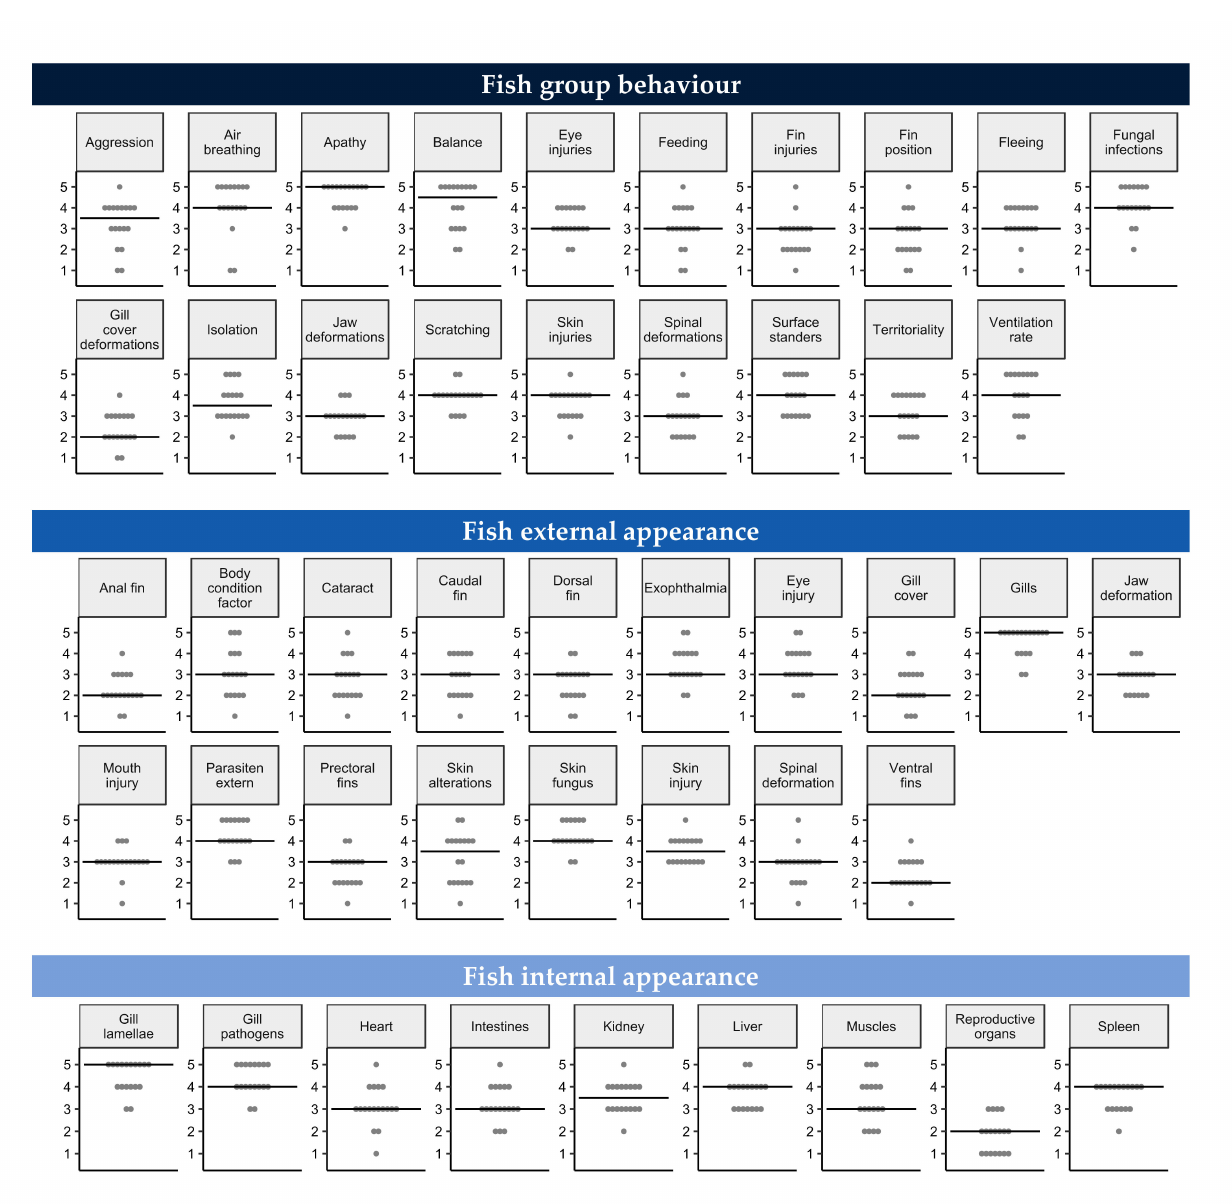
Figure A2. Results of the expert survey for the modules fish group behaviour, fish external appearance and fish internal